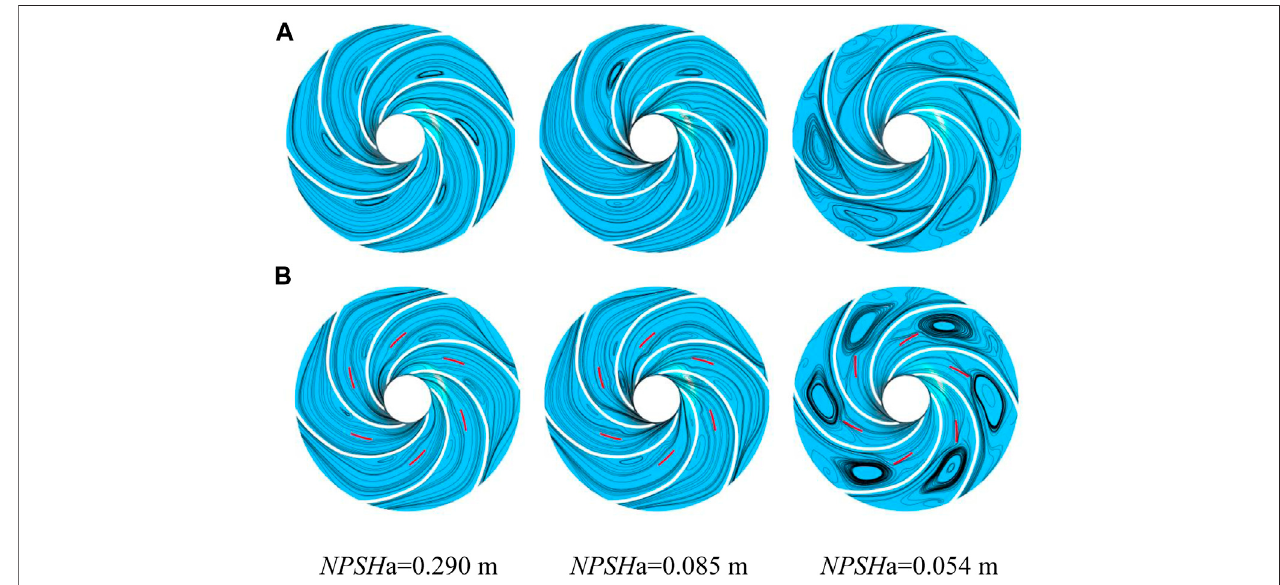
FIGURE 8 | Distribution of Streamlines: (A) original impeller and (B) B3 impeller.